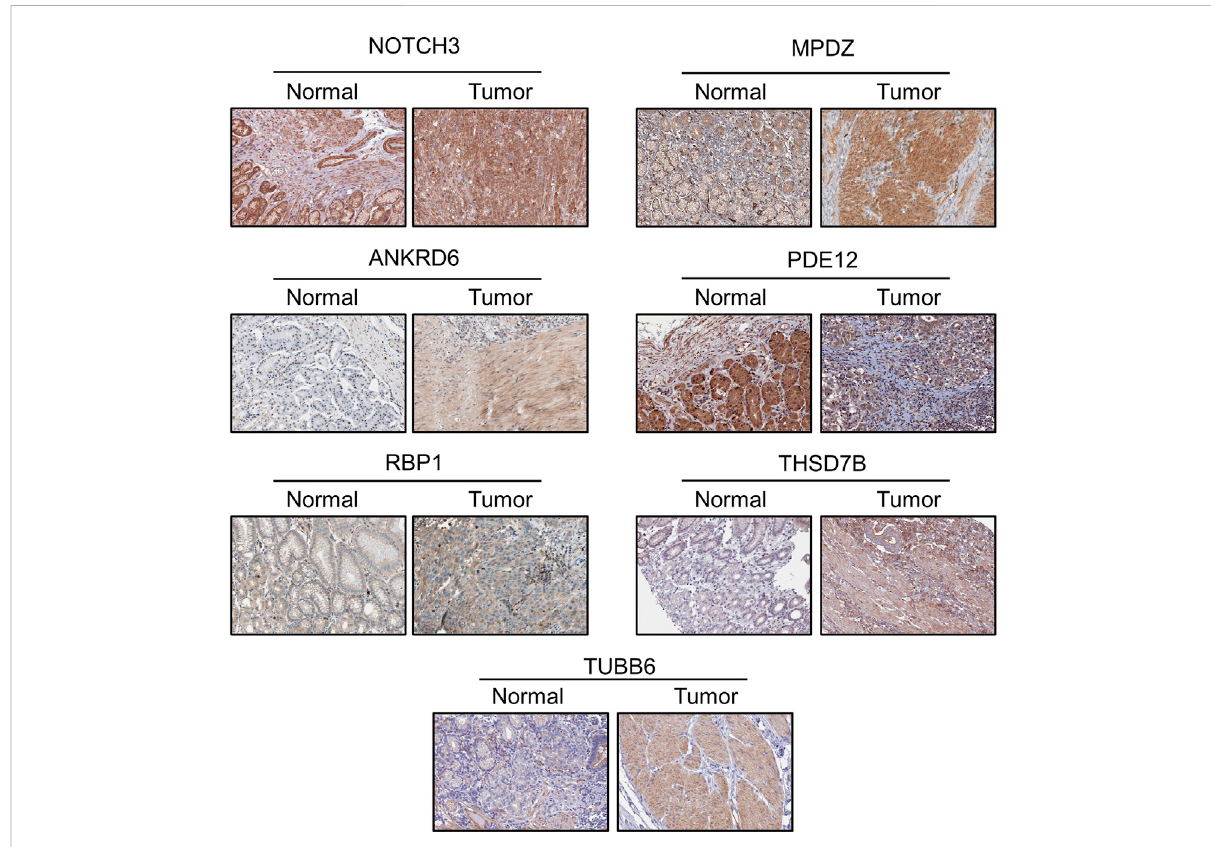
FIGURE 4 The protein level by IHC staining among normal stomach tissue and gastric cancer